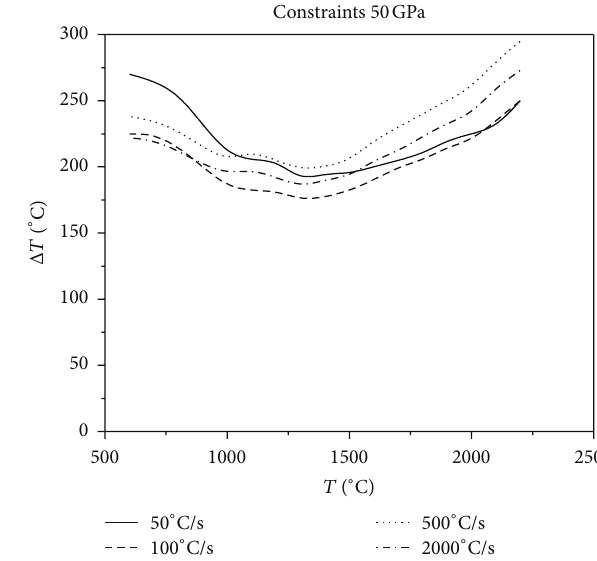
Figure 11: Relationship between critical fracture temperatures corresponding to different cooling rates and thermal shock initial temperatures under the constraints of 50 GPa.